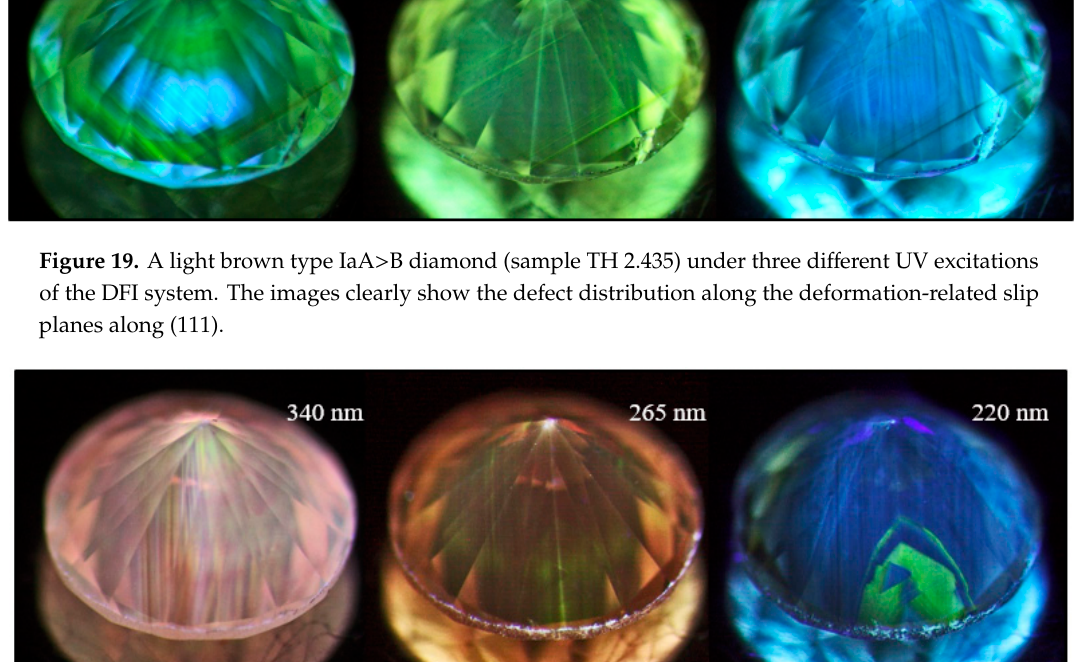
Figure 20. A pinkish brown type IaA>>B diamond (sample TH 2.440) under three different UV excitations of the DFI system. The images clearly show the defect distribution along the deformation-related slip planes along (111). At 340 nm, the main defect visible as pink PL is the 617.6/626.3 nm defect; the green H3 PL can be seen under all excitations, and at 220 nm the N3 defect is dominant.